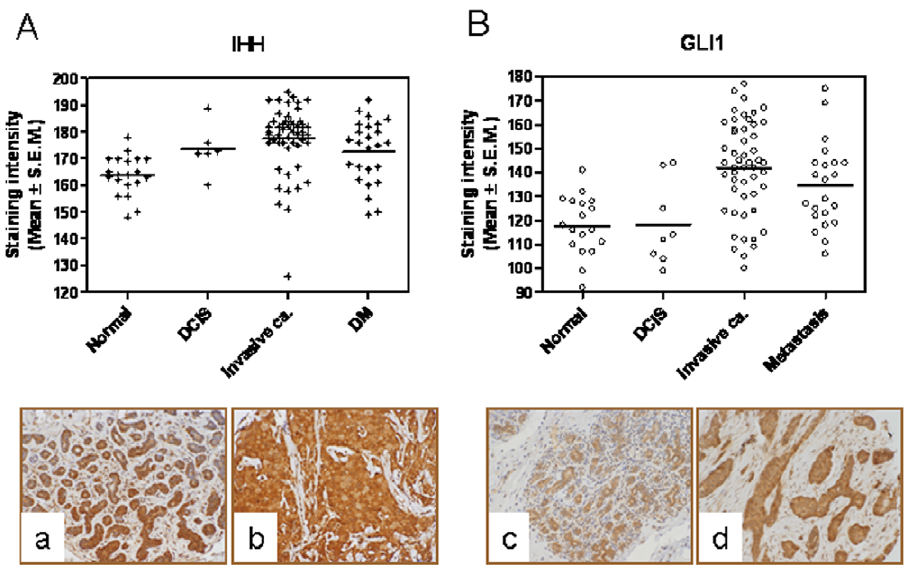
Figure 1. The Hh pathway is activated in breast tumors. Breast cancer tissues (n=75) and normal breast tissues (n=9) were immunohistochemically stained for ( A ) IHH and ( B ) GLI1 expression. The intensity of cytoplasmic staining was quantitated with computer-assisted image analysis in a Dako ACIS III Image Analysis System (Glostrup, Denmark). Staining intensities were recorded and represented as a scatter plot. The staining intensities indicating expression levels of IHH and GLI1 were significantly greater (p , 0.0001) in the tissues derived from invasive cancer (representing Infiltrating Ductal Carcinoma Grades II–IV) and from metastatic breast cancer (DM) relative to normal tissues and tissues derived from Ductal Carcinoma In Situ (DCIS). Panels a and b represent normal breast tissue and invasive breast cancer stained for IHH. Panels c and d represent normal breast tissue and invasive breast cancer stained for GLI1.